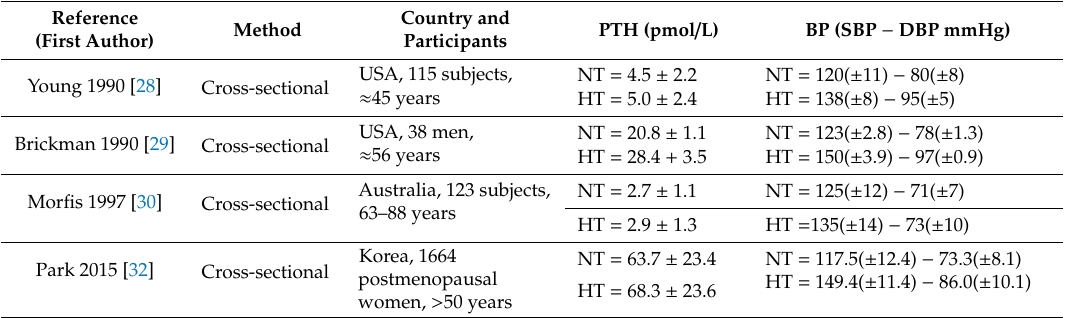
Table 1. Parathyroid hormone (PTH) serum levels and blood pressure (BP) values in normotensive and hypertensive subjects.